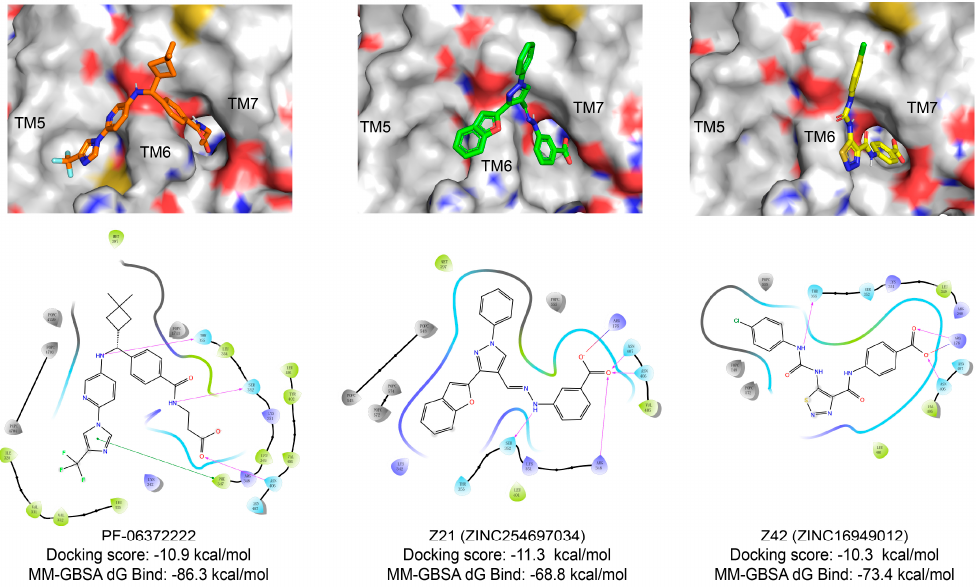
Figure 3. Comparison of binding modes of representative hits from SBVS and PF-06372222. Carbon atoms of PF-06372222, Z21 and Z42 are colored orange, green and yellow, respectively. Docking score and MM-GBSA dG Bind are in kcal/mol.